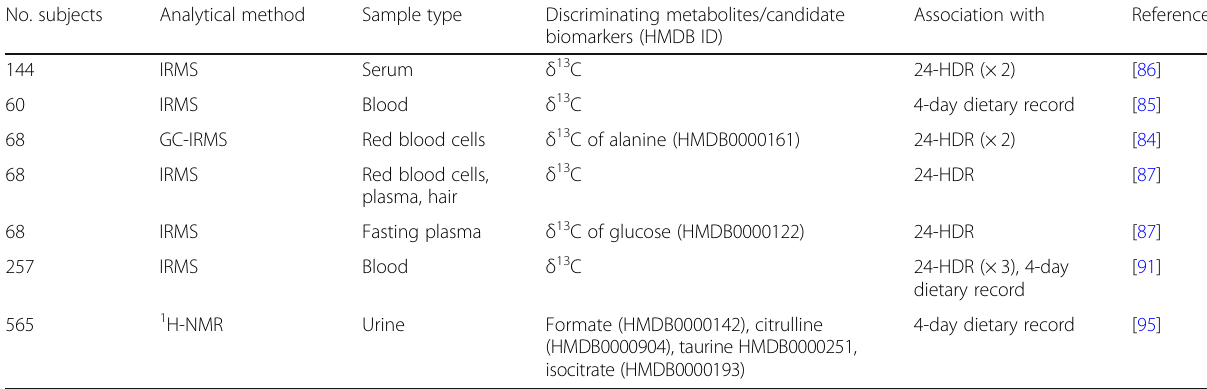
Table 5 Biomarkers of intake for sugar-sweetened beverages discovered in observational studies No.